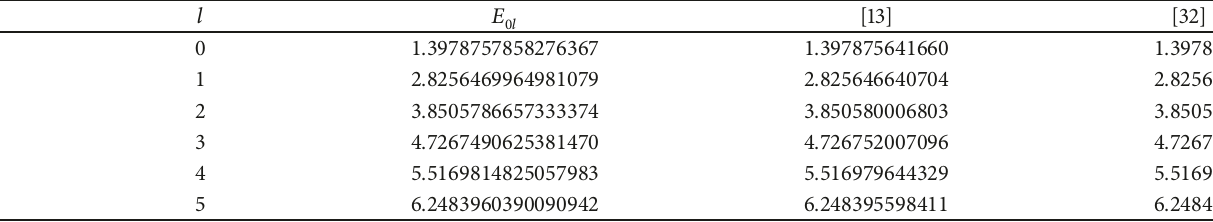
Table 2: Comparison of eigenvalues of 𝑉(𝑟) = −1/𝑟 + 𝑟 for 𝑙